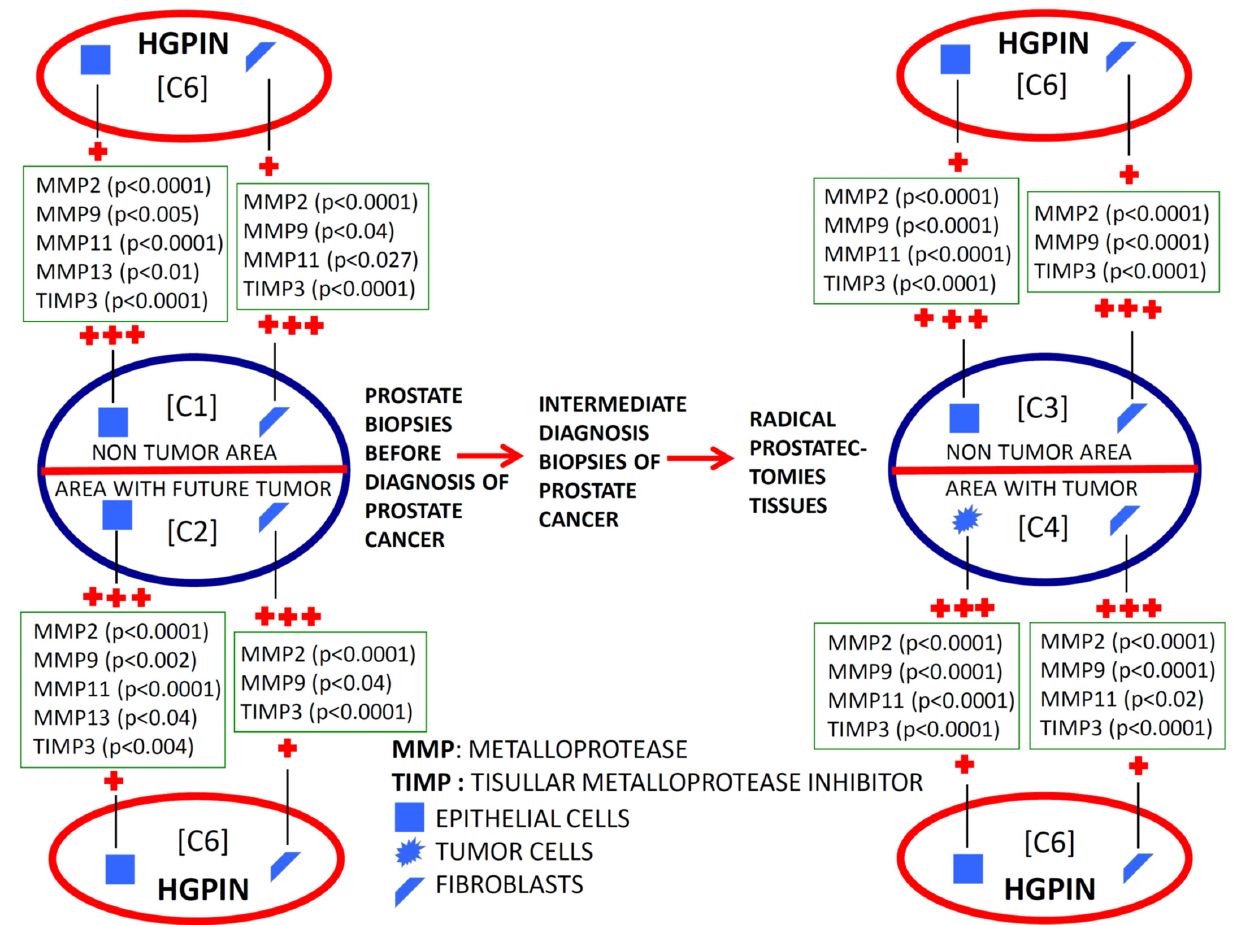
Figure 5. Schematic comparative study of the expression of MMPs and TIMP-3 by epithelial cells and by fibroblasts from high-grade prostatic intraepithelial neoplasia (HGPIN), benign prostate biopsies before the diagnosis of prostate cancer (non-tumor zones and zones with future tumor), and from paired zones from prostatectomies by prostate cancer (non-tumor zone and zone with tumor). +: lower expression; +++: higher expression. Table 1. Percentage of accuracy for the different algorithms considering MMPs/TIMP-3 expression by epithelial cells.